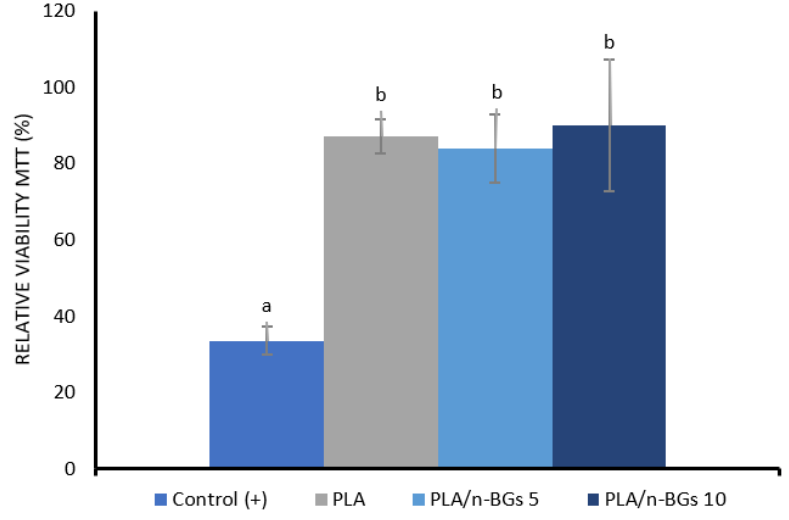
Figure 11. MTT data for the different formulations of neat PLA and PLA/n-BGS nanocomposites.